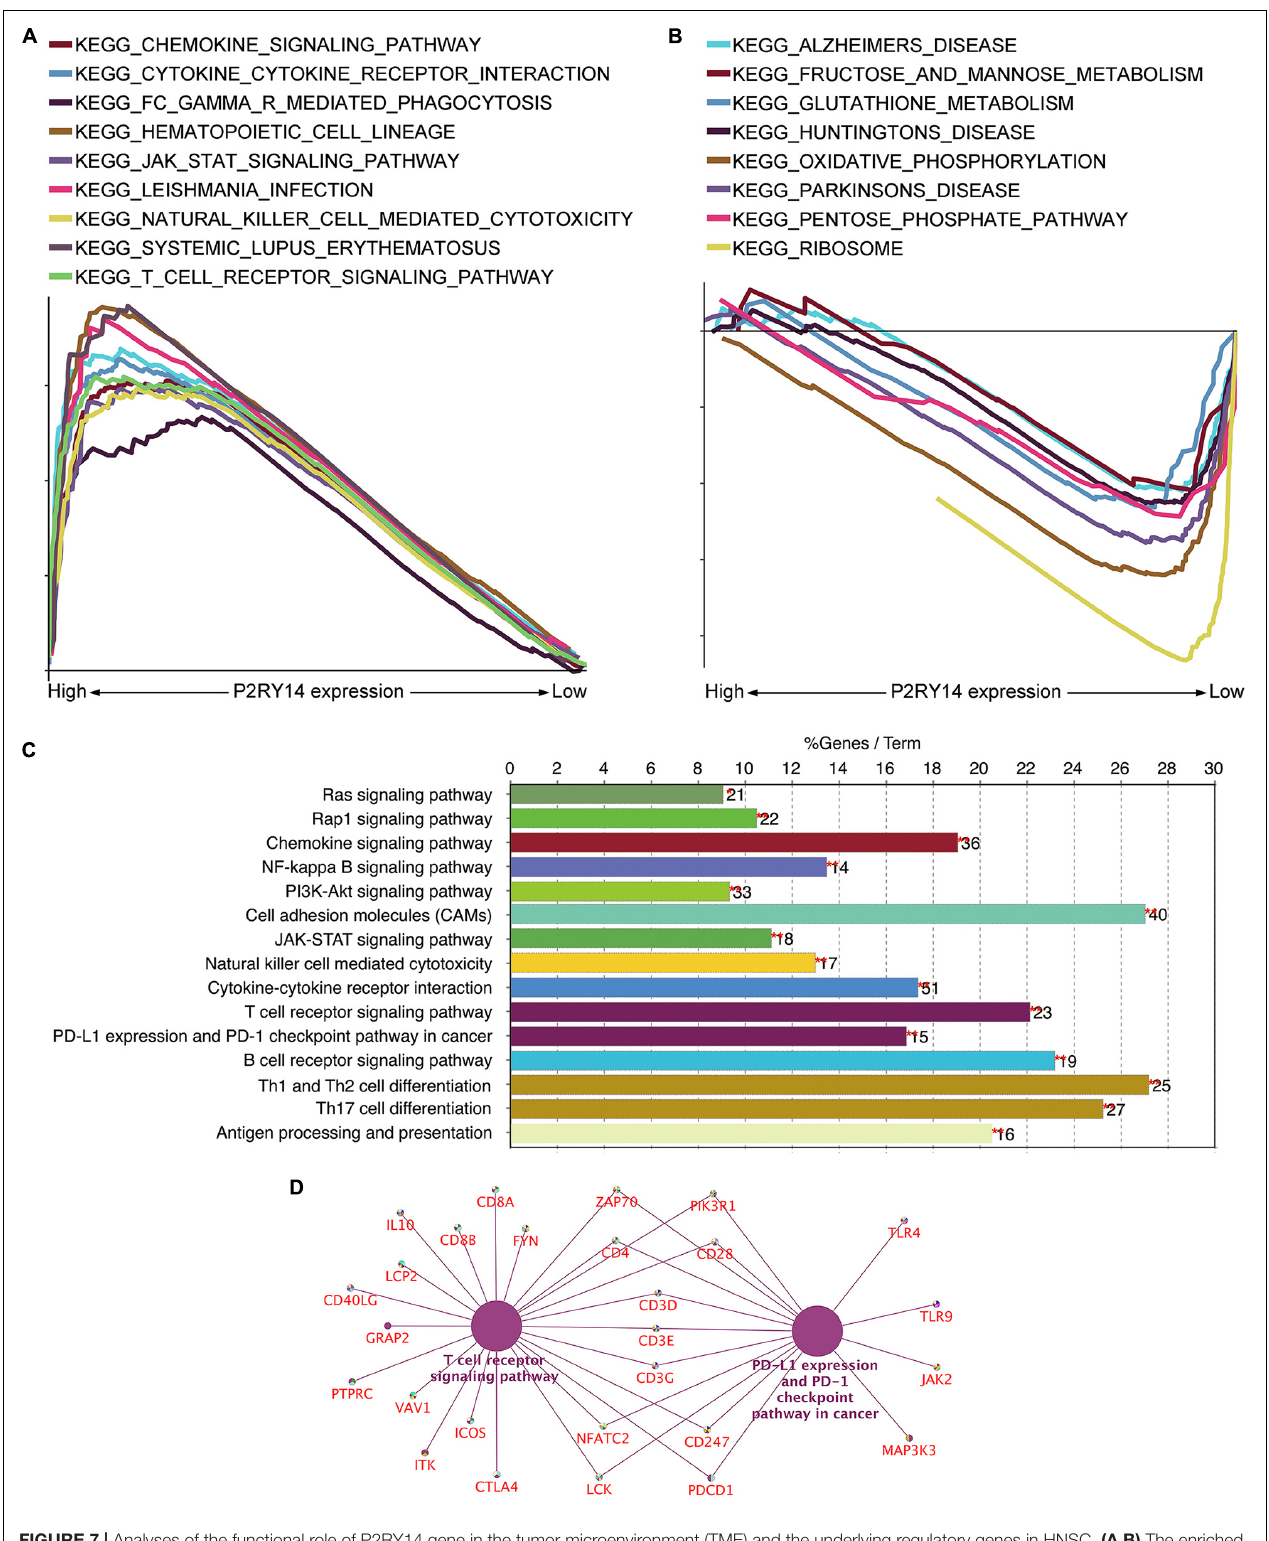
Frontiers in Genetics |